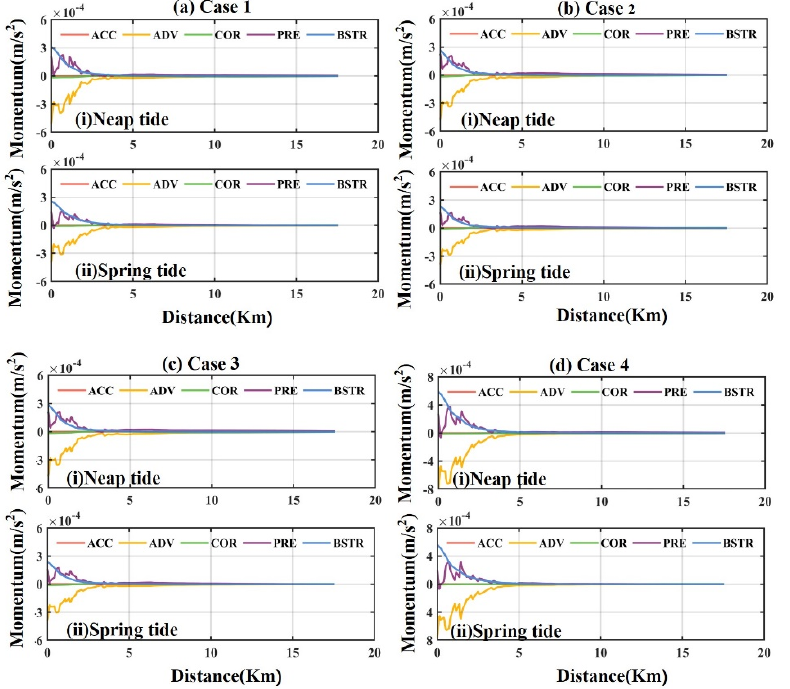
Figure 14. Depth-averaged terms in the 2-D momentum balance equations [i.e., Equation (12)] during six tidal cycles (~72 h) at section P1. ( a ) Case 1, ( b ) Case 2, ( c ) Case 3, and ( d ) Case 4.